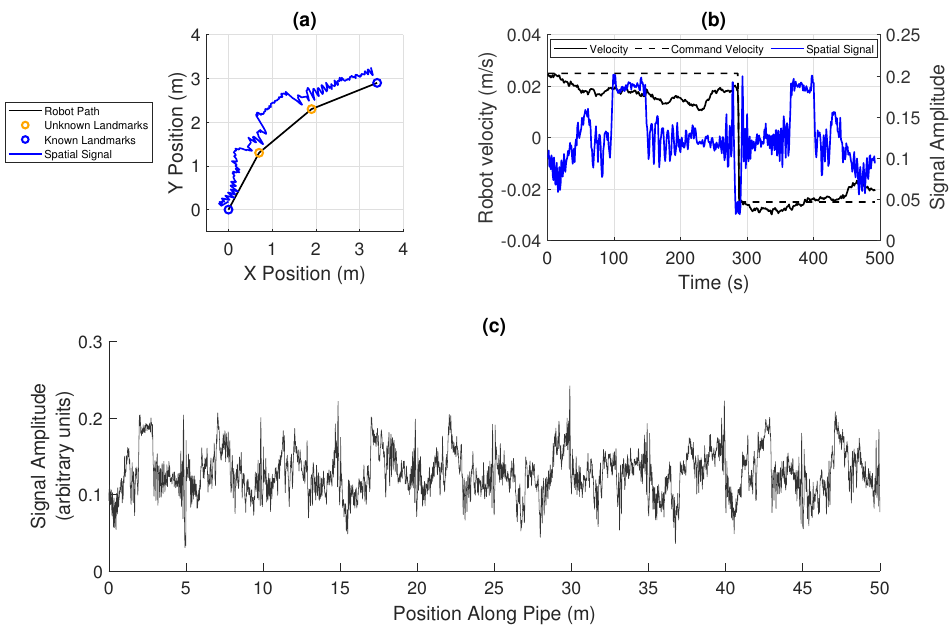
Figure 3. The creation of synthetic 1D data based on the experimental data: ( a ) the spatially varying acoustic signal superimposed on the trajectory of the robot along a pipe, illustrating how the signal would vary in the semi-two-dimensional space; ( b ) the motion of the robot along the pipe in each direction, where a fixed command velocity is given, the robot’s actual velocity drifts with additive noise, and the spatial signal can be seen to be warped due to this drift; and ( c ) a larger set of spatial signal data, simulated based on the experimental